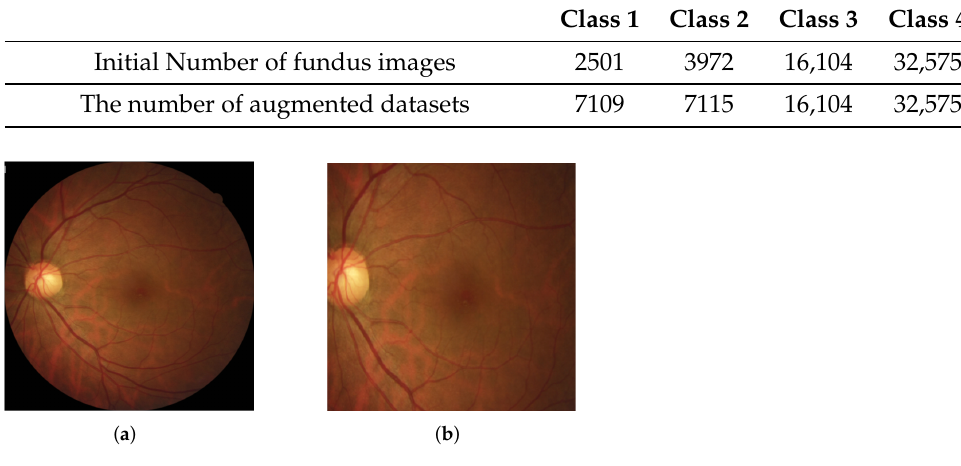
Figure 3. Before and after cropping fundus images. ( a ) before cropping; ( b ) after